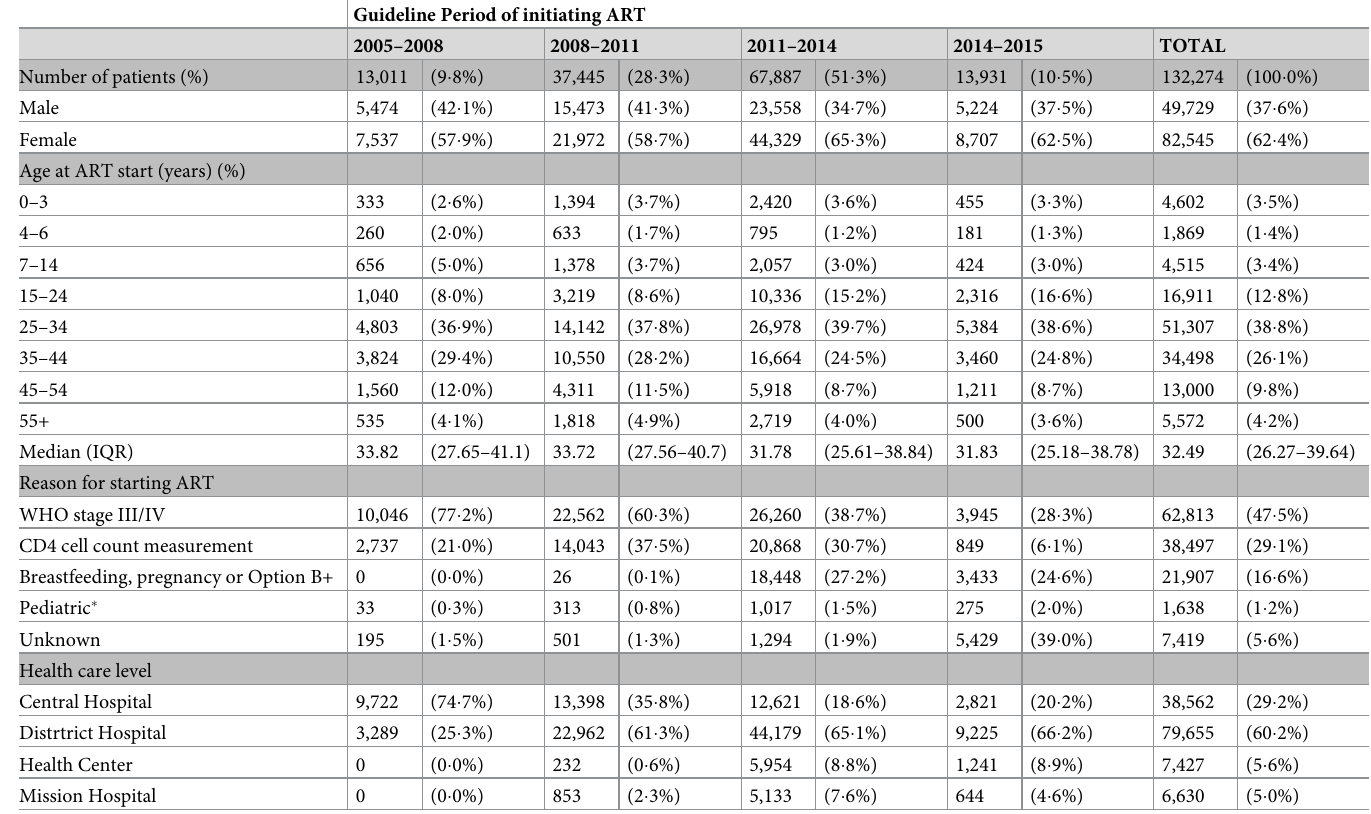
Table 1. Patient characteristics at initation of antiretroviral therapy (ART), stratified by Malawi national guideline period for ART initiation (2005–2015). Guideline Period of initiating